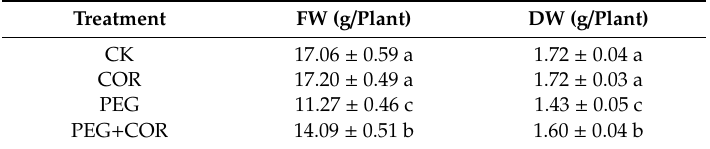
Figure 1. The morphological traits of tobacco treated with coronatine (COR) under normal and osmotic conditions. CK, normal growth conditions; COR, pretreatment with 1 nM COR; polyethylene glycol (PEG), osmotic stress induced by PEG without COR treatment; PEG + COR, pretreatment with 1 nM COR under PEG stress. Table 1. Effect of COR on biomass of tobacco seedlings under PEG treatment.